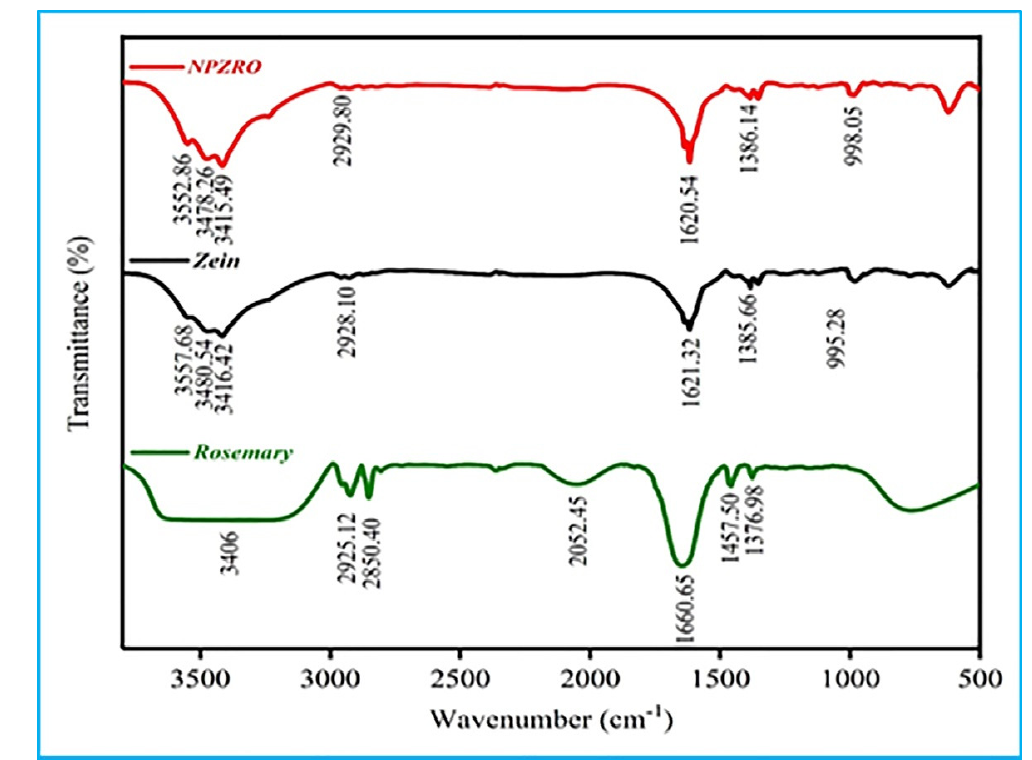
Figure 4. FT-IR spectrum of pure zein, pure RO, and NPZRO.